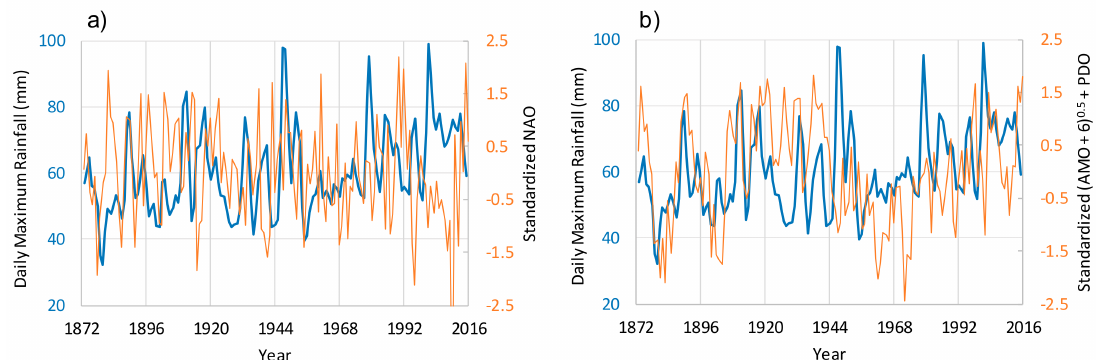
Figure 7. Comparison between daily maximum rainfall in Naples and climatological indices in the period 1873–2016: ( a ) With standardized NAO (North Atlantic Oscillation); ( b ) With standardized Atlantic multidecadal oscillation and Pacific decadal oscillation (